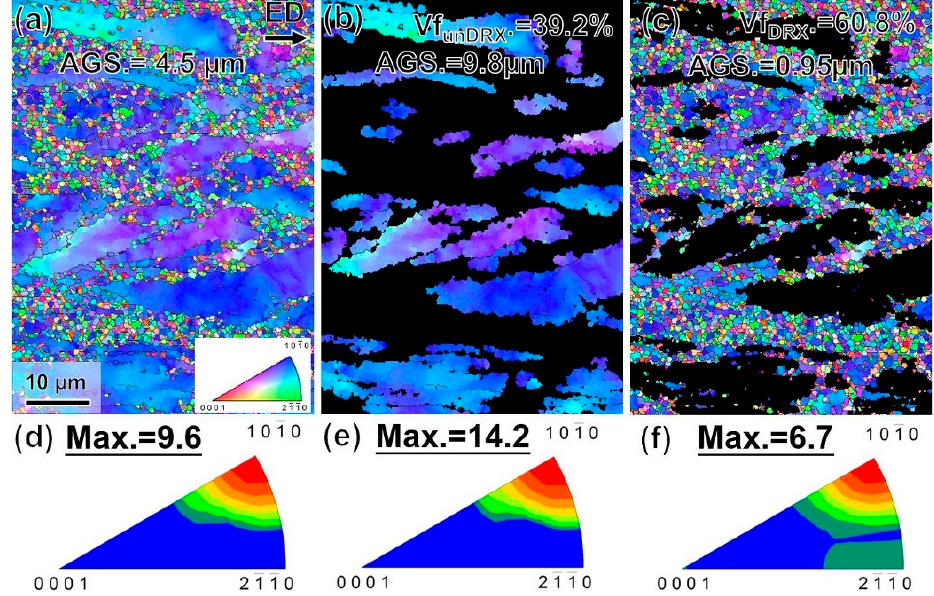
Figure 3. Inverse pole figure maps ( a – c ) and corresponding inverse pole figure ( d – f ) of as-extruded BX11 alloy: ( a , d ) overall, ( b , e ) unDRXed, and ( c , f ) DRXed regions.